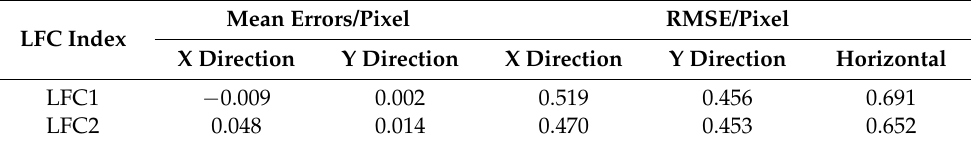
Figure 5. Residuals after internal calibration of laser footprint cameras (LFCs). ( a ) Residuals after internal calibration of LFC1. ( b ) Residuals after internal calibration of LFC2. Table 3. Residual statistics after internal calibration of laser footprint cameras